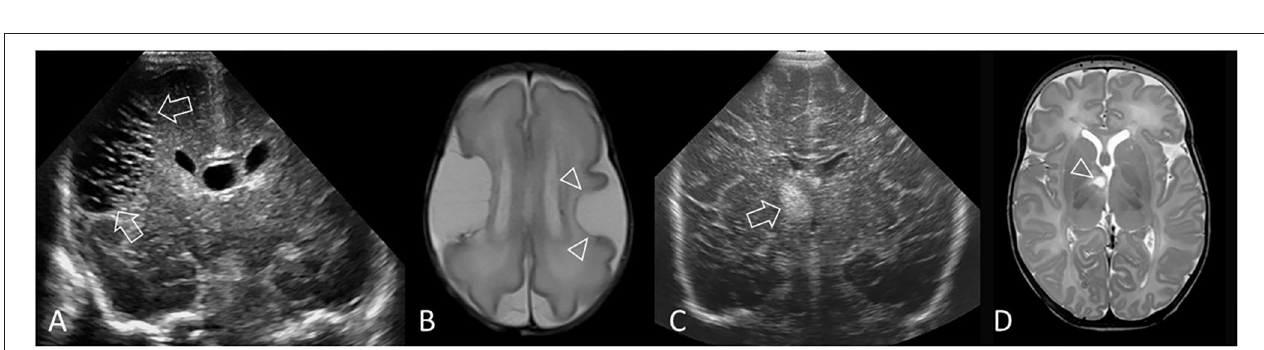
FIGURE 11 | PVHI with eventual evolution into multiple, unilateral cystic lesions separate from the lateral ventricle in a preterm infant (GA 25 weeks). (A) Coronal ultrasound scan 5 days after birth showing the right-sided GMH-IVH and large echodensity in the periventricular white matter adjacent to, but not communicating with, the lateral ventricle (arrow). (B,C) Coronal and right parasagittal scans 11 weeks later show cystic lesions in the parietal white matter that do not communicate with the lateral ventricle (arrow). PVHI adjacent to, but not communicating with, the lateral ventricle often evolves into multiple smaller cystic lesions rather than one large porencephalic cyst. This small cluster of white matter cysts could be mistaken for grade 2 ischemic WMI. However, review of the baseline cUS exam and understanding the evolution of injury clarifies that this represents variant cystic evolution of PVHI.